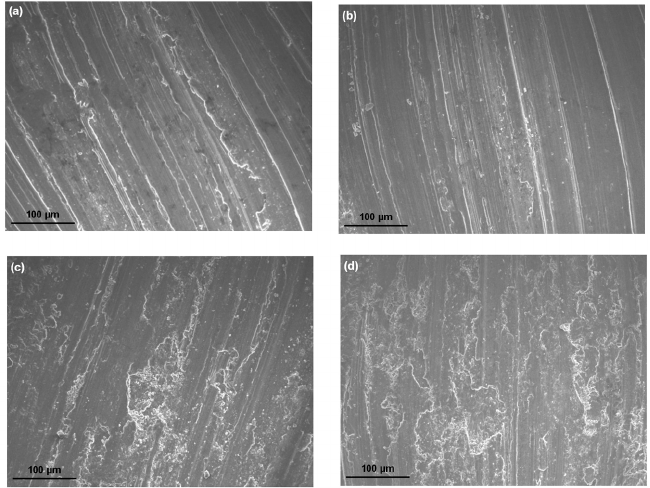
Figure 5. Worn surface morphologies of the Mg-Sn alloys after the pin-on-disc wear test: ( a ) as cast; ( b ) one-pass (1N); ( c ) two-pass (2N); and ( d ) four-pass (4N).